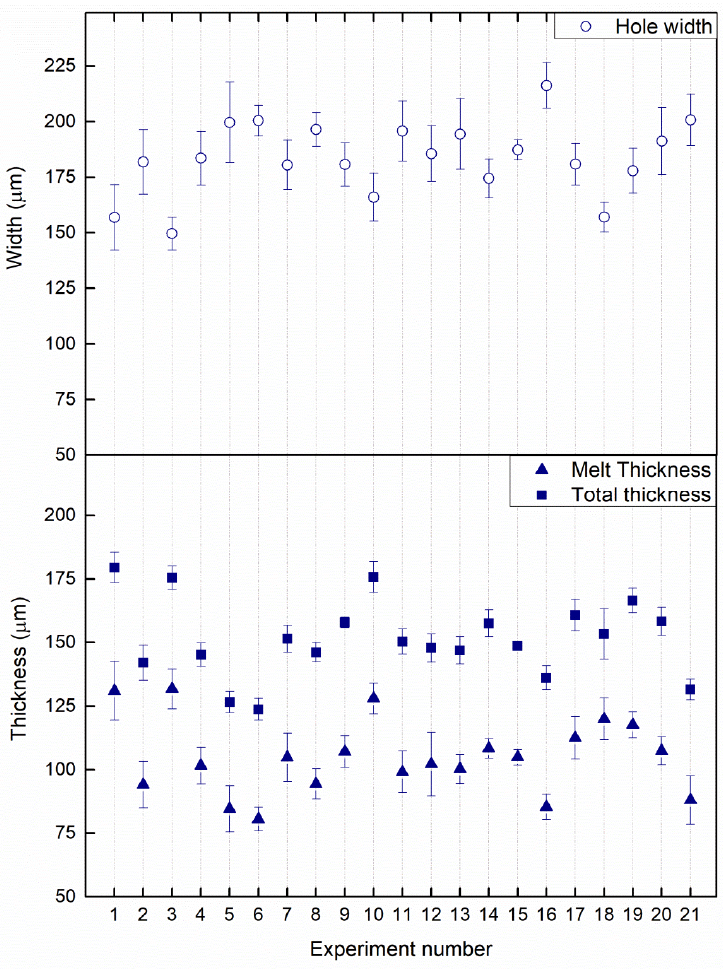
Figure 7. Dimensional results obtained from the thin-walled tubes. Considering all of the experiments, the average difference between the melt thickness and the total thickness was 46.60 ± 10.37 µ m. This value can be correlated with the starting powder size (D90 of 40 µ m) once it is known that a partial melt of these particles occurs in the inner face of the wall, as in the outer